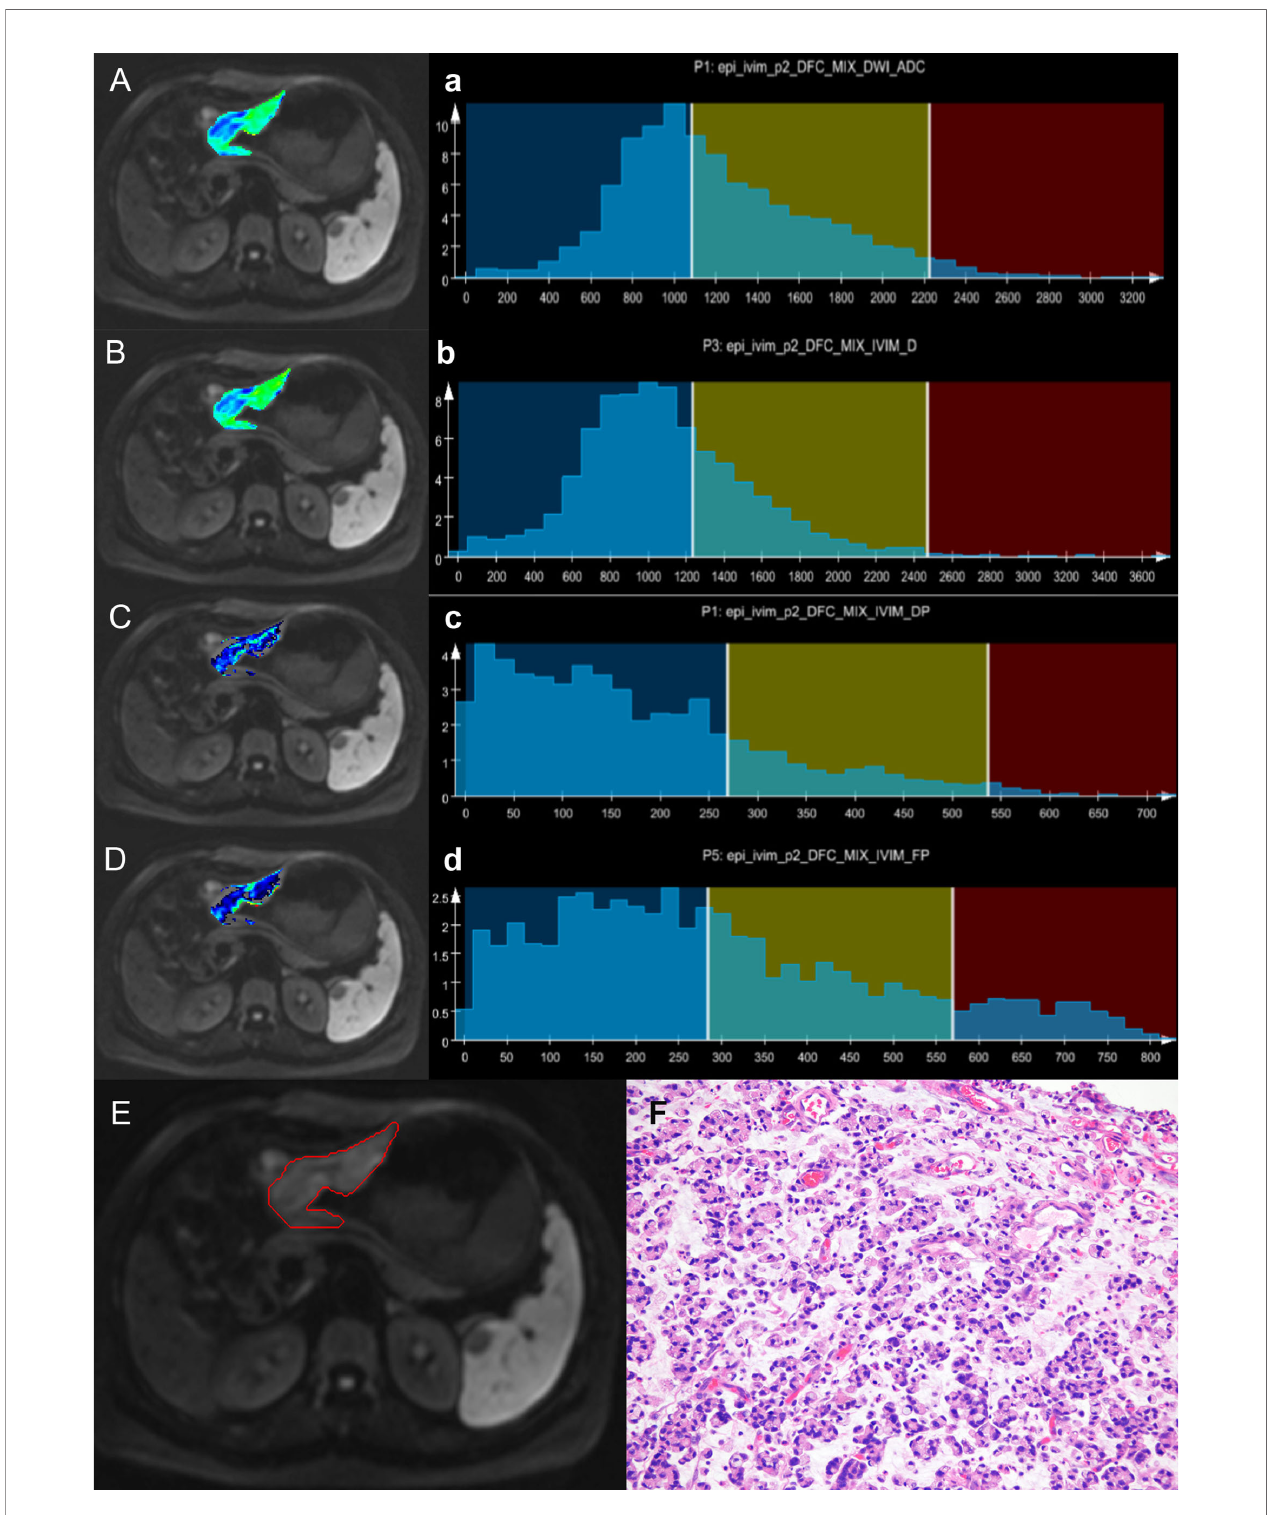
FIGURE 3 | A case of gastric body cancer. The colored regions in (A – D) represent the lesion parameters maps; (a – d) show histogram parameter distributions for the whole tumor (ADC, Dslow, Dfast, and FP presenting sequentially). (E) Shows the contour of the region of interest (ROI). (F) A photomicrograph of an HE stained tissue section demonstrating a poorly differentiated signet-ring cell